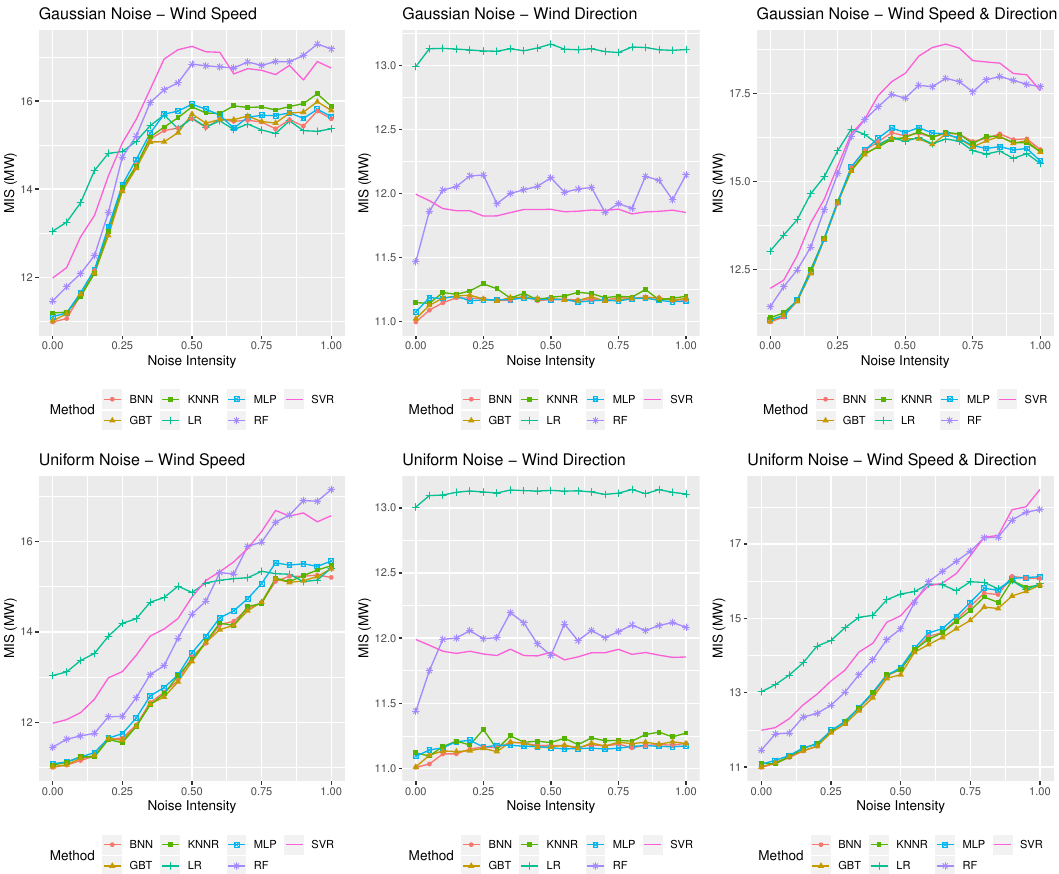
Figure 8. Forecasting performance in terms of wind power prediction intervals (MIS, measured in MW) of the statistical and ML methods considered in this study for the Rokas wind farm when different types of noise and noise intensities are considered. The three panels on the top display the accuracy of the methods for the case of the Gaussian noise of various intensities, σ , applied to wind speed forecasts, wind direction forecast, and both, respectively. The three panels at the bottom display the same results for the case of the uniform noise of various intensities s